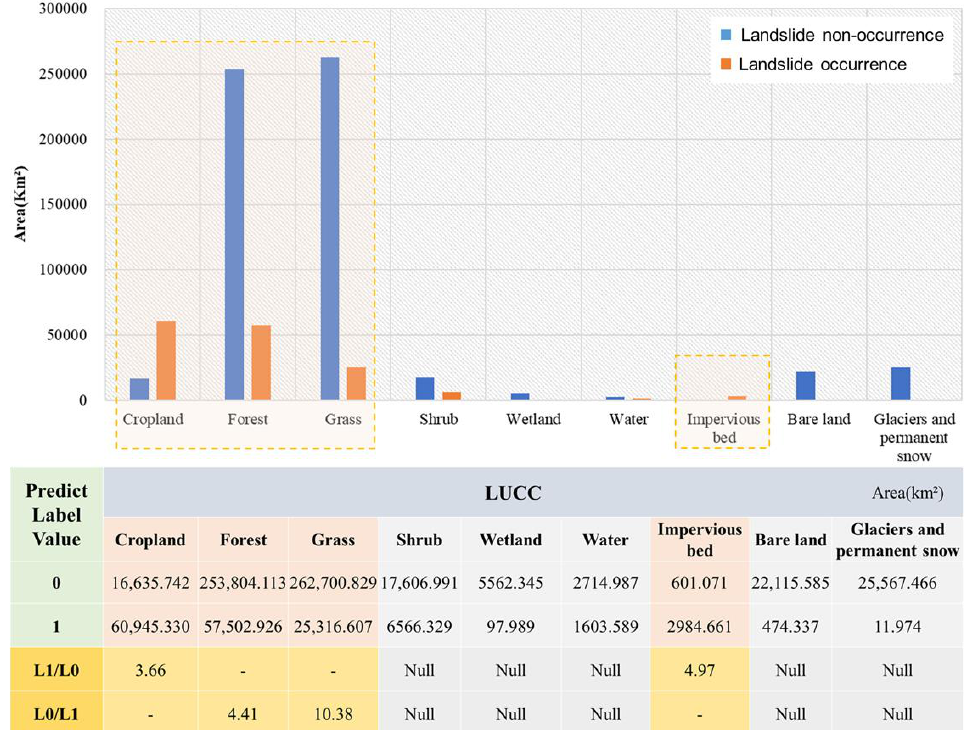
Figure 10. Verification and evidence for LS map over the Hengduan Mountains region. ( a ) The land- slide susceptibility classification; ( b ) landslide susceptibility in the southern part of the area. Panels of ( c – e ) show Esri satellite imagery with different land covers: ( c ) human settlements, ( d ) terrace, and ( e ) forest area.